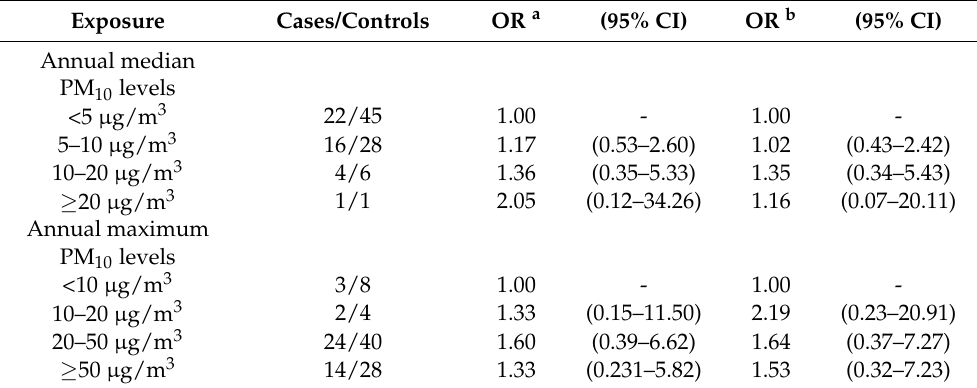
Table 3. Risk of amyotrophic lateral sclerosis according to particulate matter (PM 10 ) exposure in subjects with stable residence within five years of diagnosis using fixed